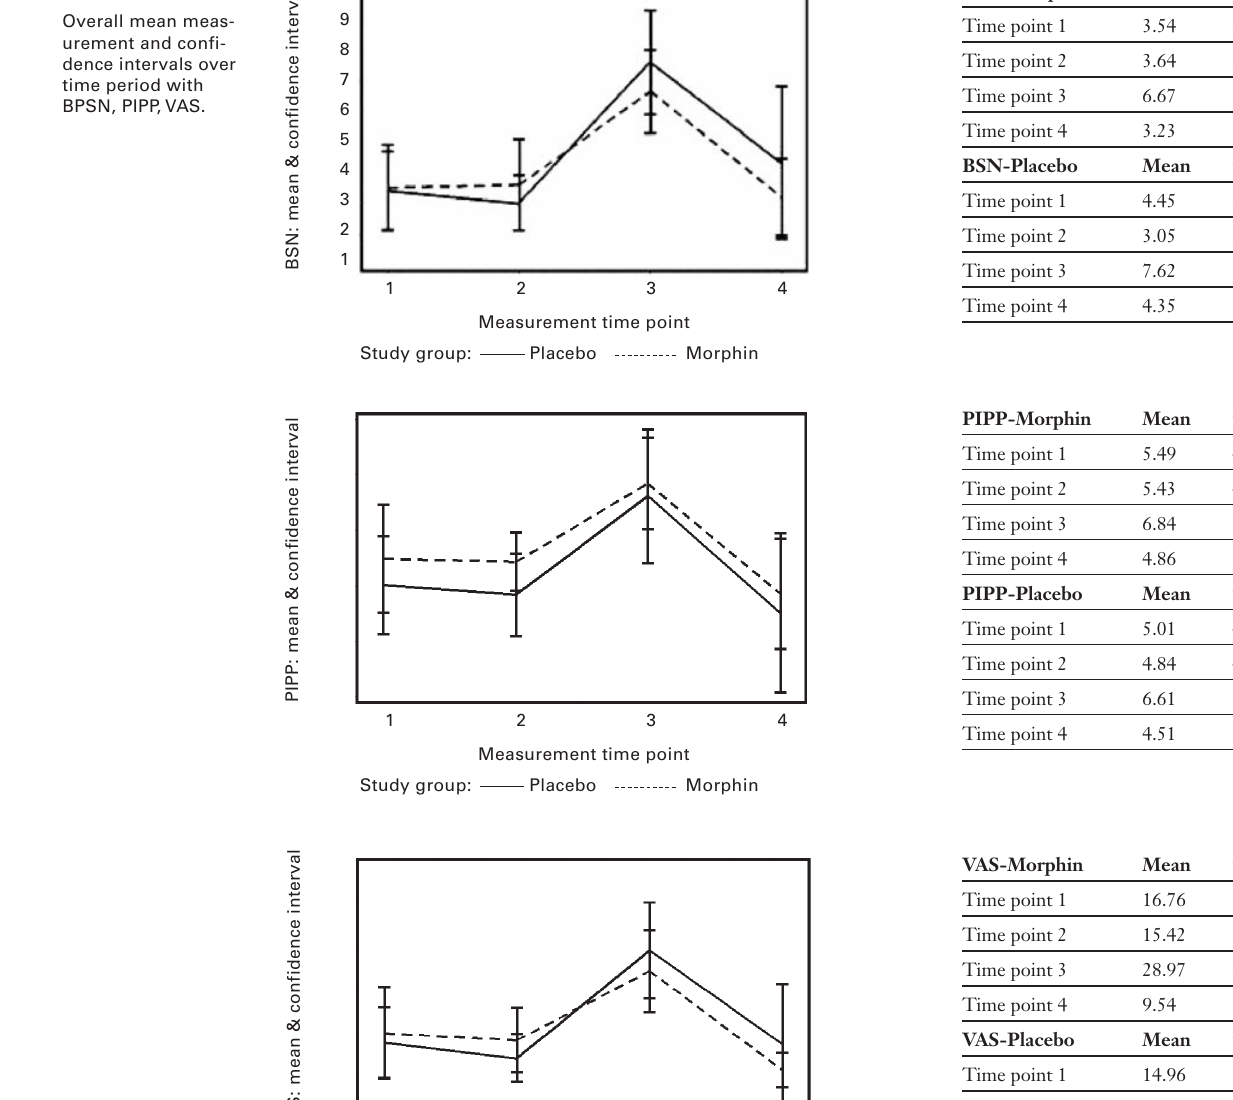
Figure 2 Overall mean meas- urement and confi- dence intervals over time period with BPSN, PIPP,